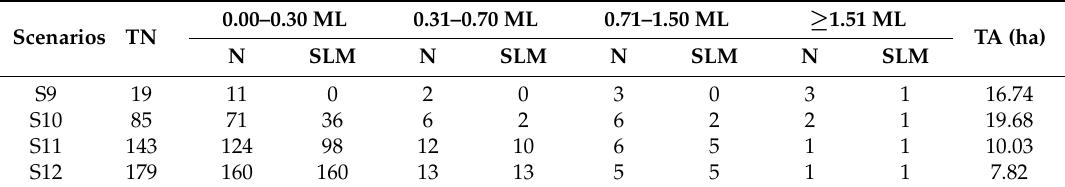
Table 7. TN, N, SLM, and TA of Scenarios S9–S12 for the main